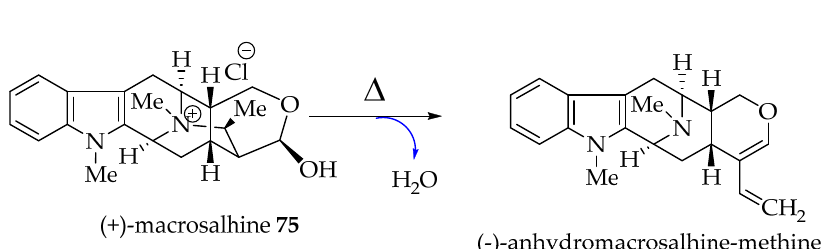
Figure 6. Pyrolysis of (-)-macrocarpamine 31 and macrosalhine 75 to generate key olefin 33.